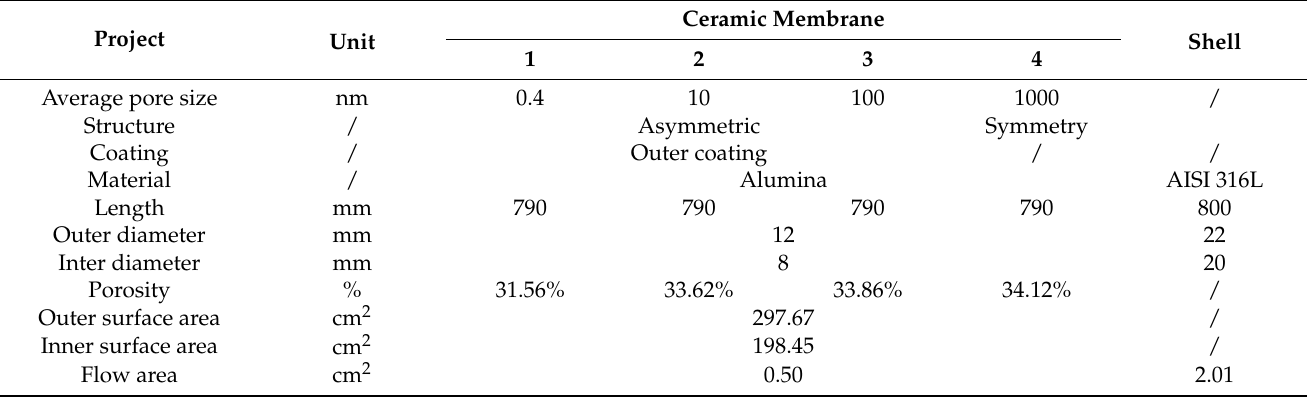
Table 1. Structural parameters of the ceramic membrane